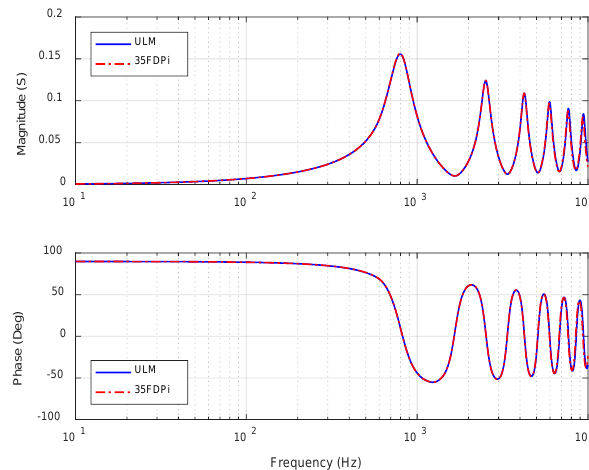
Figure 13. Cable admittance comparison for Case Study #2.